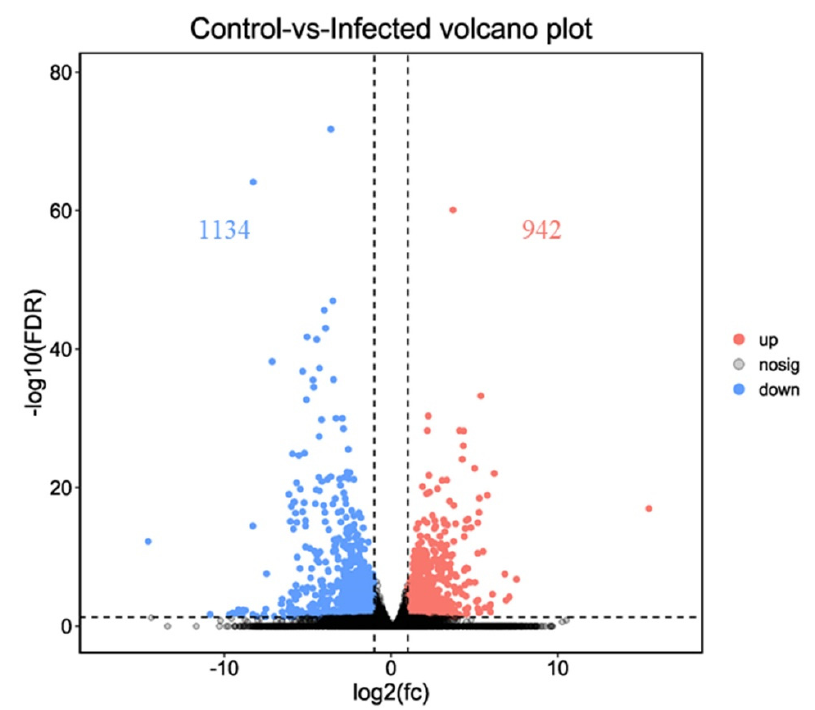
Figure 3. Volcano plot of the differentially expressed genes of greenfin horse-faced filefish (upregulated differentially expressed genes (red); downregulated differentially expressed genes (blue); non-differentially expressed genes (black)).